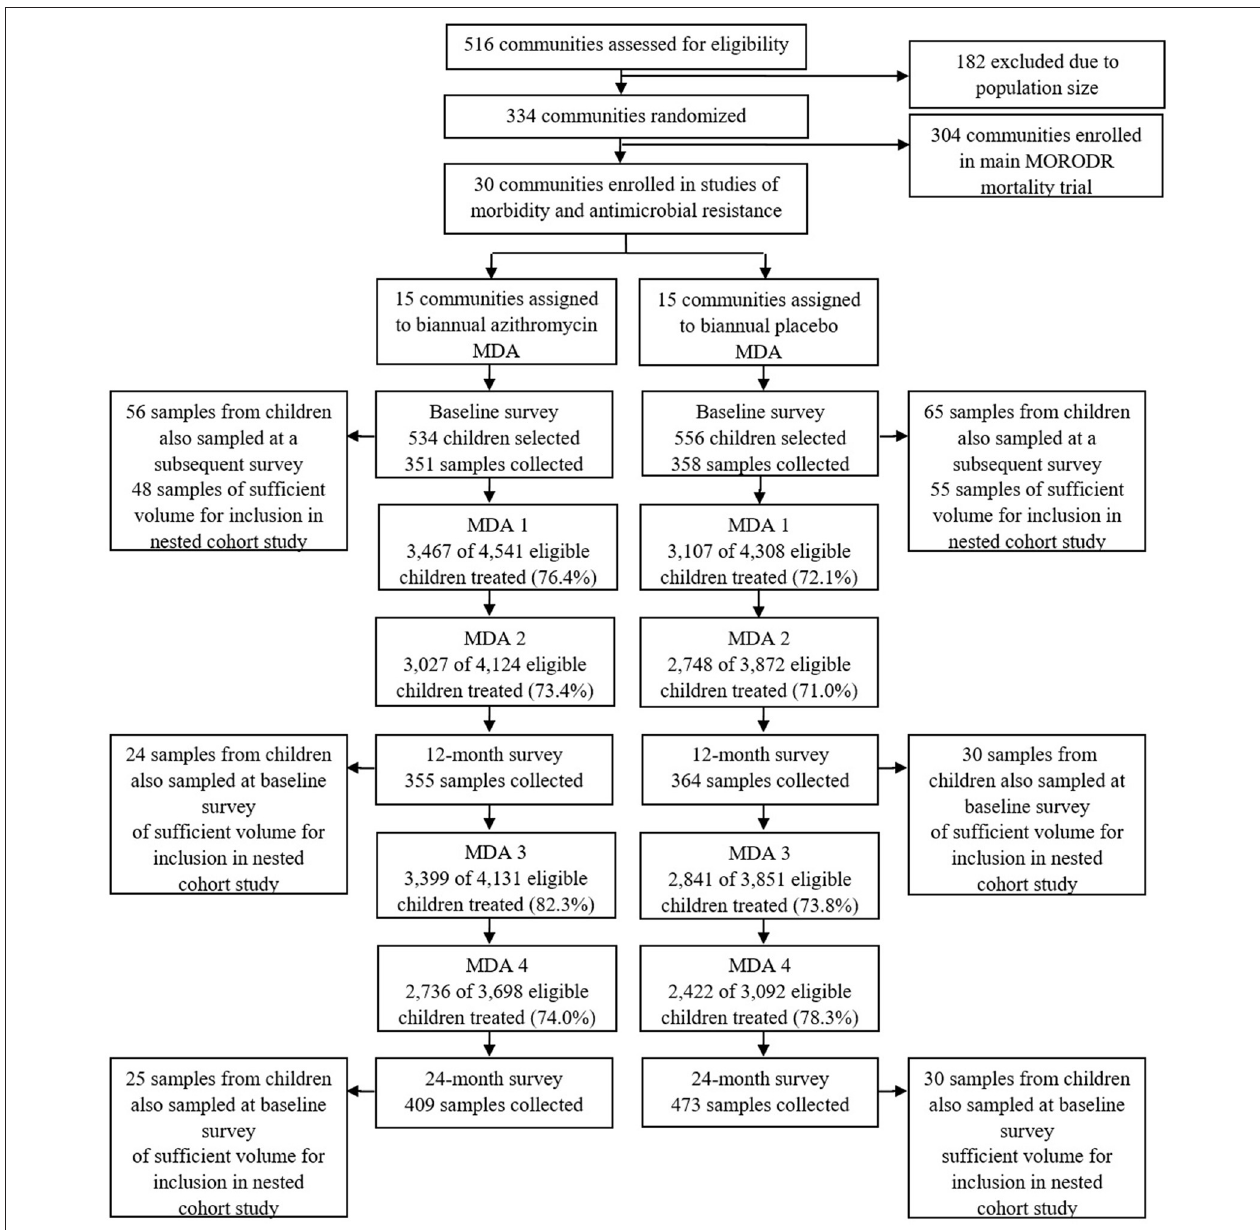
FIGURE 1 | Study flow. Study flow for the cross sectional survey of carriage of antimicrobial resistance and selection of samples for the nested cohort